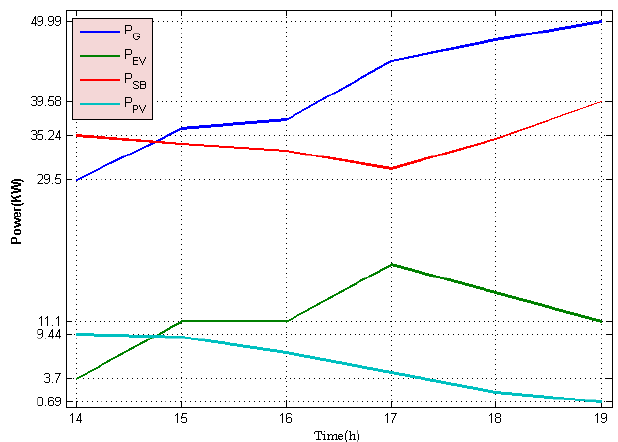
Figure 2. Power curves analyzed from the building in the base scenario.